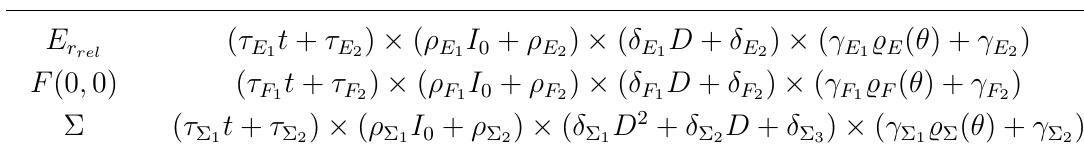
Table 2. Summary of parameters extracted from the IRED images, including the effect of the IRED orientation angle. D = d − 2 and (cid:37) E , F (0 , 0) or Σ r rel